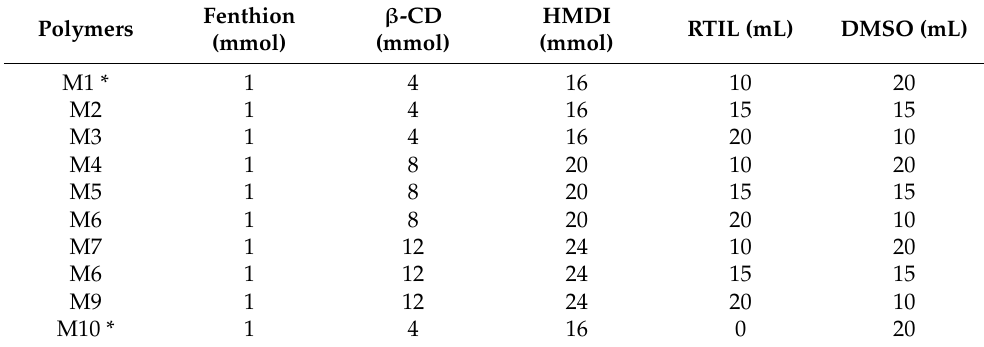
Table 1. Protocols of MIPs synthesis for fenthion.